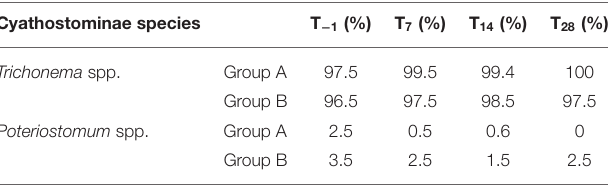
TABLE 2 | Cyathostominae third-stage larvae developed in pooled fecal samples of treated (Group A, n = 11) and untreated (Group B, n = 11) donkeys at study time-points (T − 1 -T 28